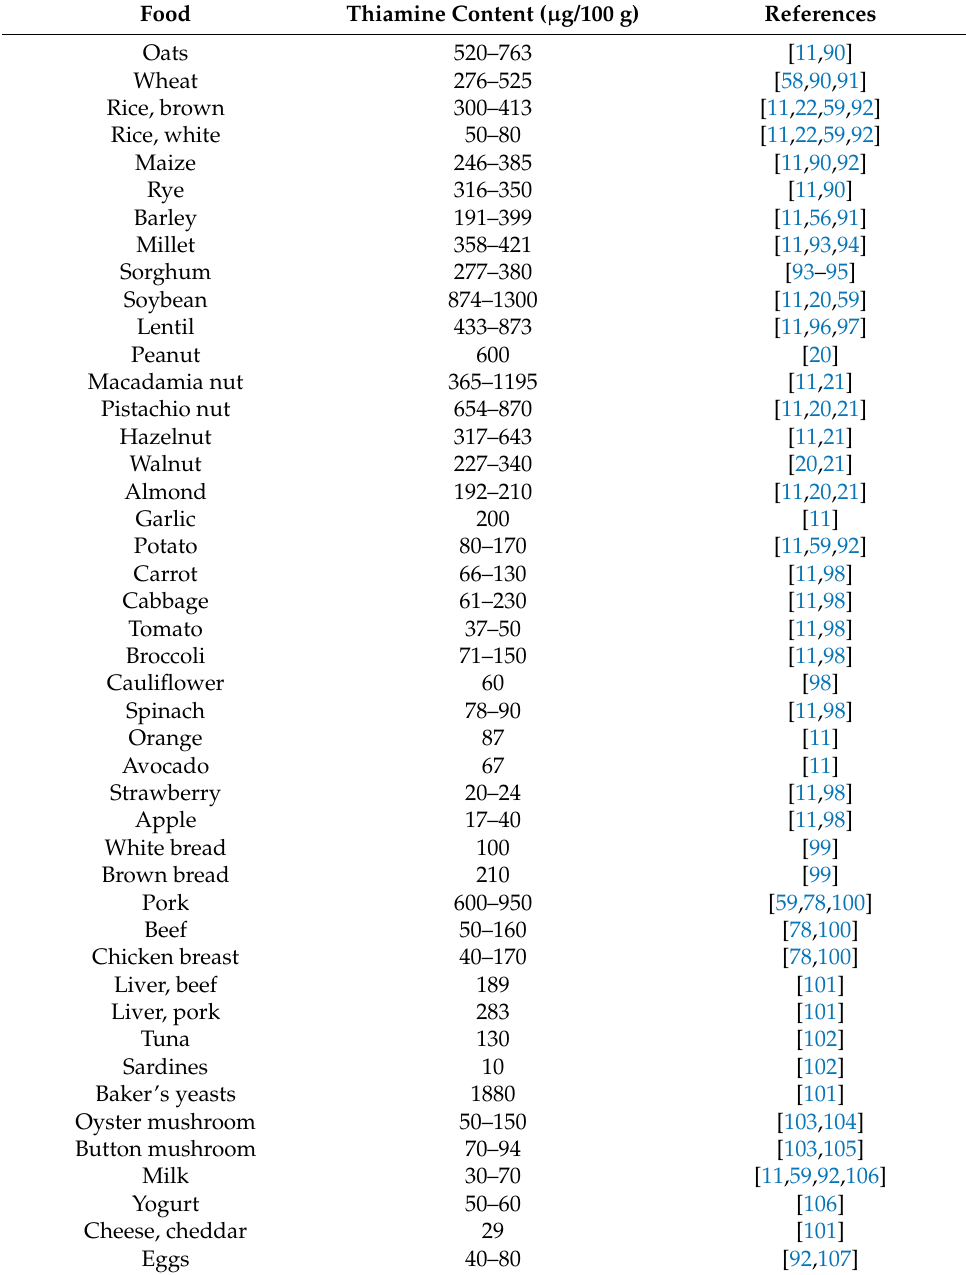
Table 1. Thiamine contents in selected